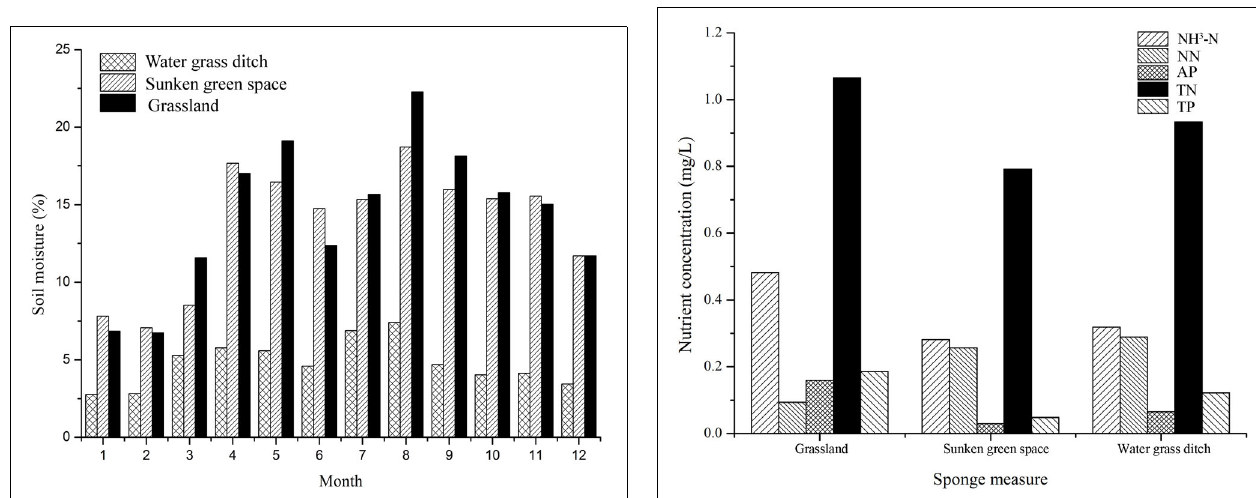
FIGURE 7 | Changes of average soil moisture content in different months under different sponge measures.